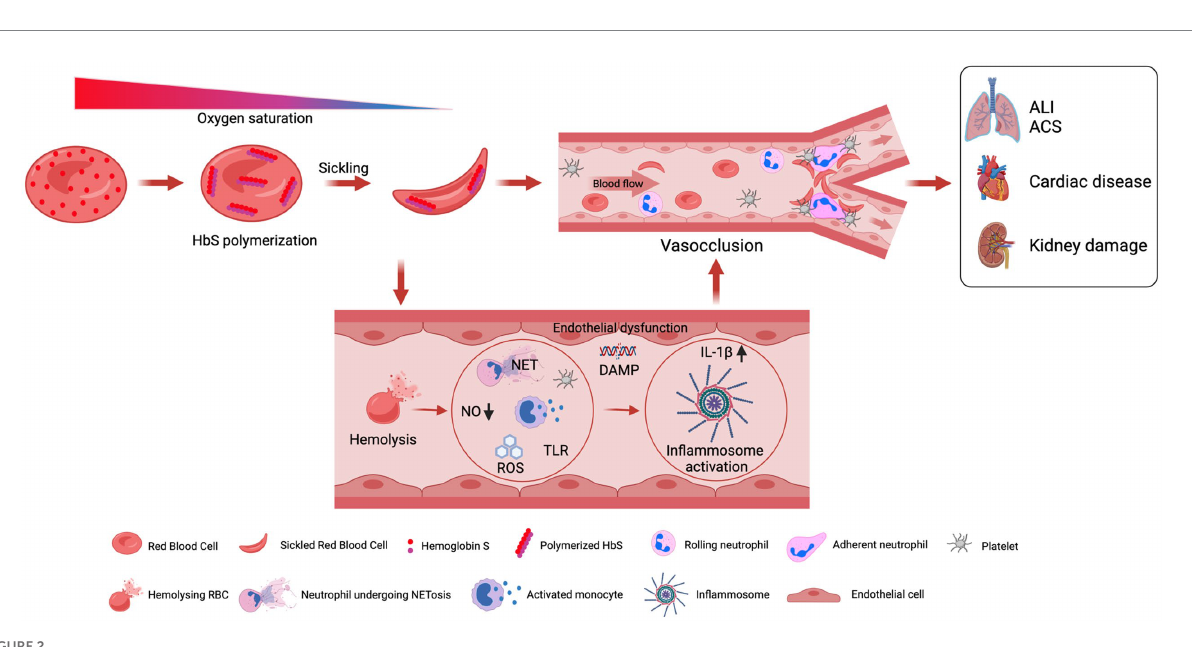
FIGURE 2 A graphical illustration of pathophysiologies associated with sickle cell